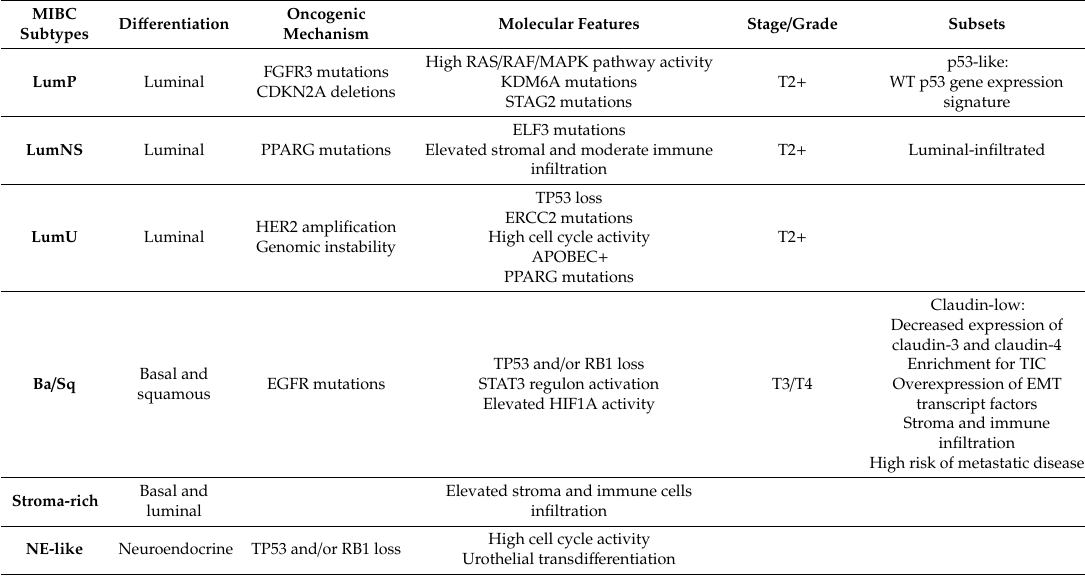
Table 2. Molecular subtypes of muscle invasive bladder cancer and their main